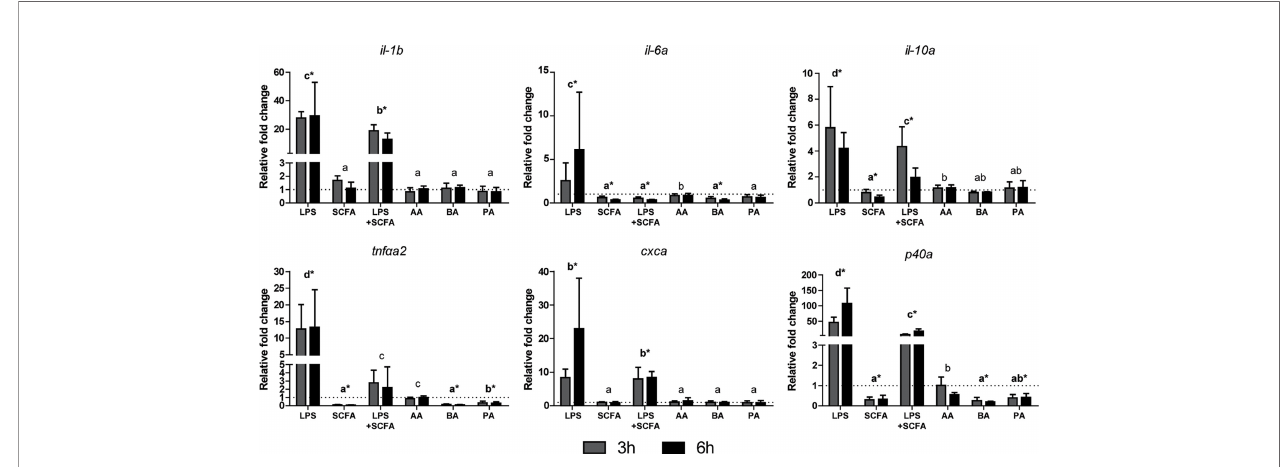
FIGURE 6 | SCFAs reduce the expression of several cytokines ex vivo stimulated head kidney leukocytes. Gene expression after 3 (grey bars) and 6 (closed bars) h of stimulation with LPS (30 µg/ml), SCFA mix (2.5 mM), LPS, and SCFA mix or the three SCFAs at the concentration they were included in the mix; acetate 1.55 mM (AA), butyrate 0.25 mM (BA), and propionate 0.765 mM (PA), compared to unstimulated HKLs (dotted line). Bars indicate mean ± SD of n = 5 experiments performed independently. Signi fi cant differences between groups were assessed by the linear mixed model followed by the Bonferroni post hoc test. Groups with different letters are statistically different from one another where “ a ” indicates the lowest value, groups indicated with asterisk (*) are signi fi cantly different from unstimulated HKLs.